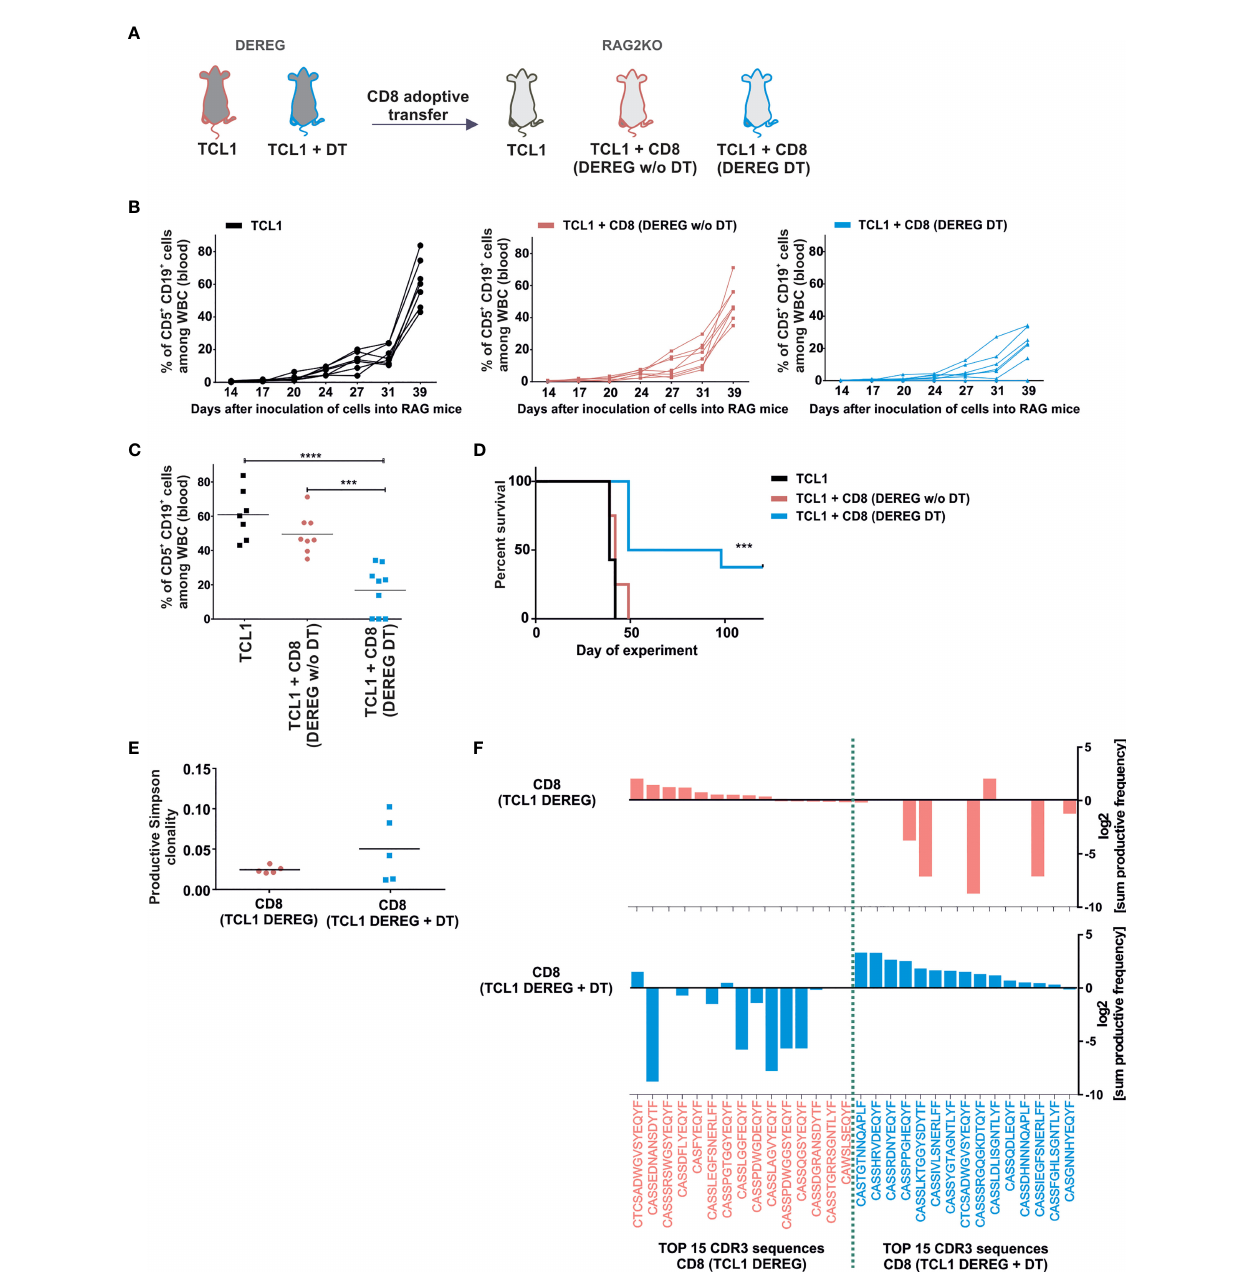
FIGURE 2 | Depletion of Tregs in TCL1 leukemia-bearing DEREG mice results in the expansion of CD8+ lymphocytes capable of eradicating leukemic cells. (A) The graph presenting a scheme of the experiment. DEREG mice were treated according to scheme from Fig1A. Then 5 x 10 6 of splenic CD8 + T cells isolated with magnetic beads from untreated (DEREG w/o DT) or DT-treated (DEREG DT) leukemic DEREG mice were injected to RAG2-KO mice following the injection of TCL1 (CD5 + CD19 + ) cells. (B, C) The percentage of leukemic cells (CD5 + CD19 + ) assessed at indicated time points in the peripheral blood of RAG2-KO mice: TCL1 leukemia-injected mice (black lines), TCL1- and CD8 + -injected mice (CD8 + isolated from TCL1 leukemia bearing-DEREG w/o DT, pink lines), and TCL1- and CD8 + - injected mice (CD8 + isolated from leukemia-bearing DEREG treated with DT, blue lines). Each line represents an individual sample (mouse), (B) and on day 39 th (C) , each dot represents an individual sample (mouse). The graphs represent mean results from two independent experiments, n = 7-9, Mann-Whitney U test ***p ≤ 0.001, ****p < 0.0001. (D) The survival plot summarizing the results from two independent experiments, n = 7-9, log-rank survival test ***p ≤ 0.001. (E) The productive Simpson clonality of CD8 + lymphocytes sorted from untreated or DT-treated mice analyzed in immunoSEQ Analyzer (from Adaptive Biotechnologies), n = 5. (F) The top 15 amino acid sequences of CDR3 TCR b with the highest sum frequency (total amount of clones with a given sequence in all tested mice), of CD8 + lymphocytes sorted from untreated (pink) or DT-treated TCL1 leukemia-bearing DEREG mice (blue). The Graphs present log2 transformation of % sum frequency of a given sequence in untreated (pink, upper graph) and DT- treated TCL1- injected DEREG mice (blue, lower graph), n =